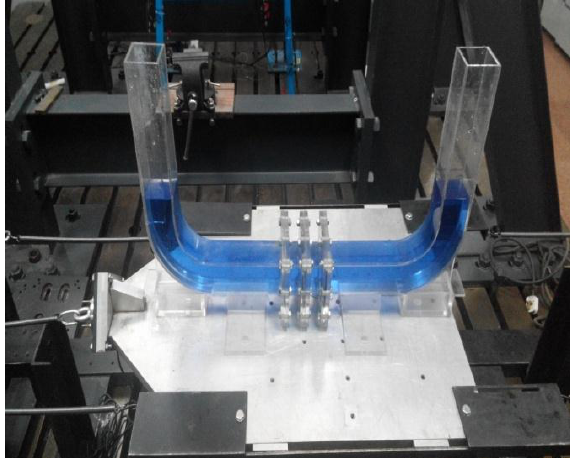
Figure 2. Regular TLCD No.